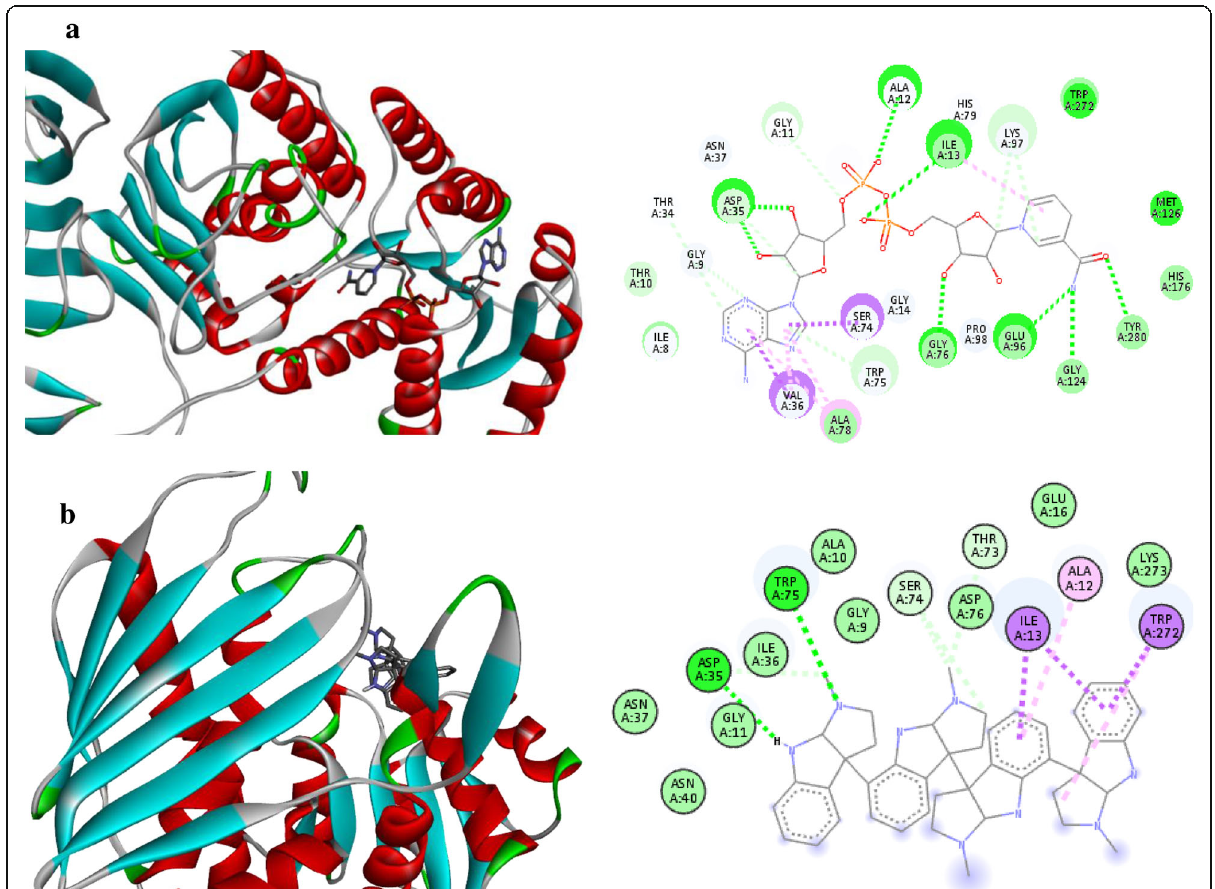
Fig. 7 Interaction of ligands with EJJ83173 protein. a ZINC68563949, a commercially available drug from the ZINC database binds to EJJ83173 with a binding energy of − 9.5. b TCM ligand 45055, a traditional Chinese medicine, binds to EJJ83173 protein with a binding energy of − 9.8. Higher negative binding energy accounts for better protein-ligand interaction and